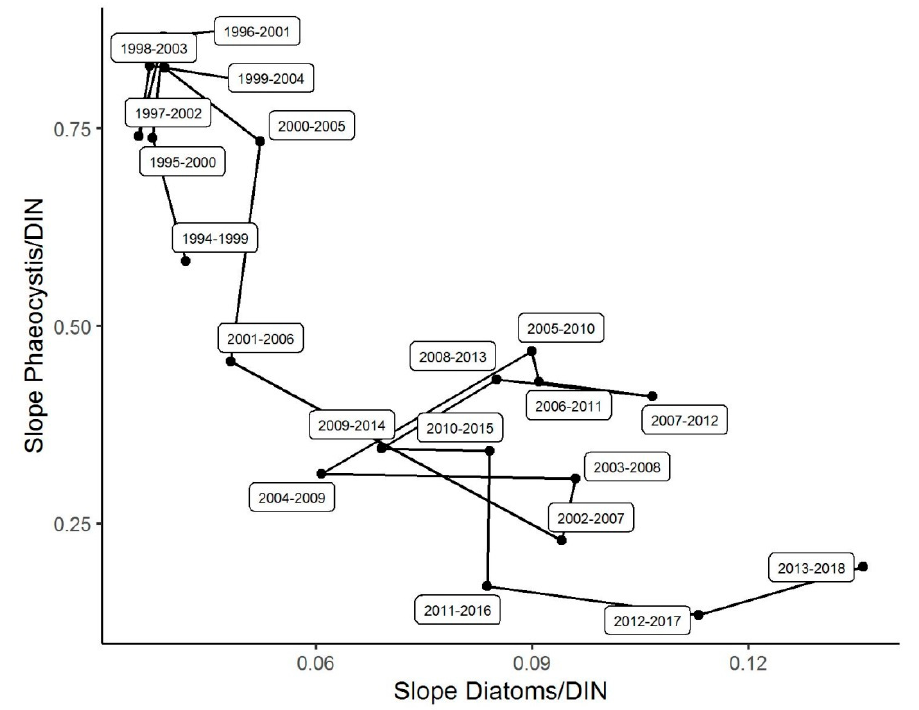
Figure 13. Temporal trajectory of the relationship between the slope of the Phaeocystis versus Dissolved Inorganic Nitrogen (DIN) and the diatom-versus-DIN regressions, by six-year sliding period.